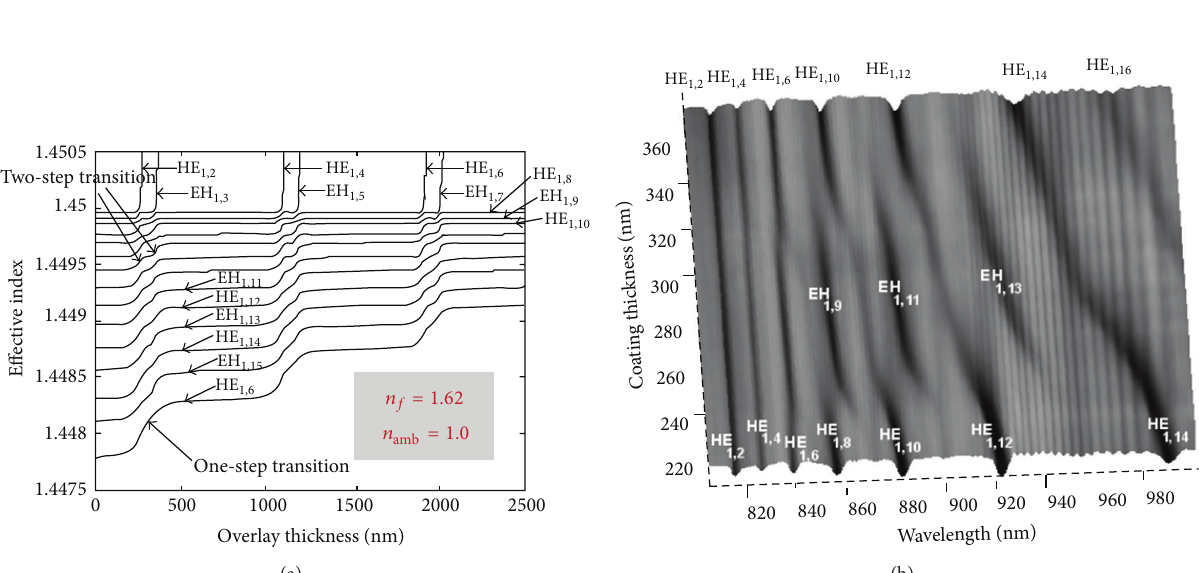
Figure 12: (a) The transition region. (b) Mode conversion and mode reorganization (taken from